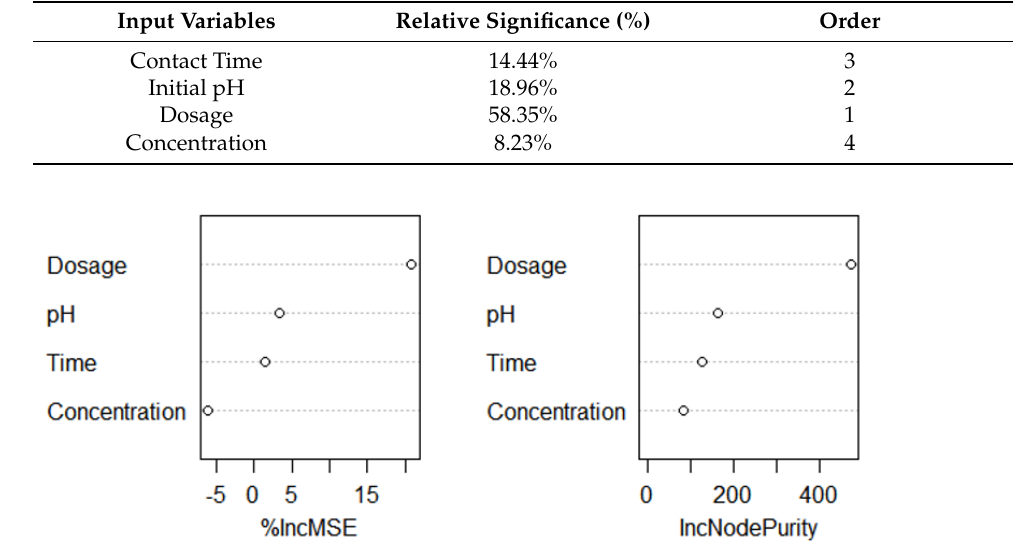
Figure 22. The relative impact of the input variables obtained by R-studio.